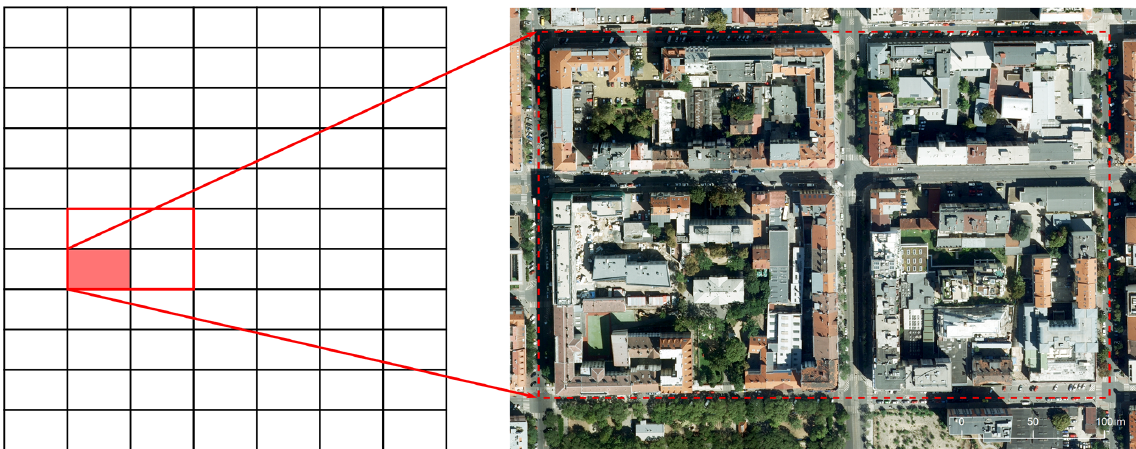
Figure 1. Design of model domains; black-bordered rectangles represent the parent domain; red-bordered rectangle represents the child domain. Solid red rectangle represents one unique domain with the real environment before multiplication. Projection: WGS 84 / UTM zone 33N; orthophoto source: Prague Institute of Planning and